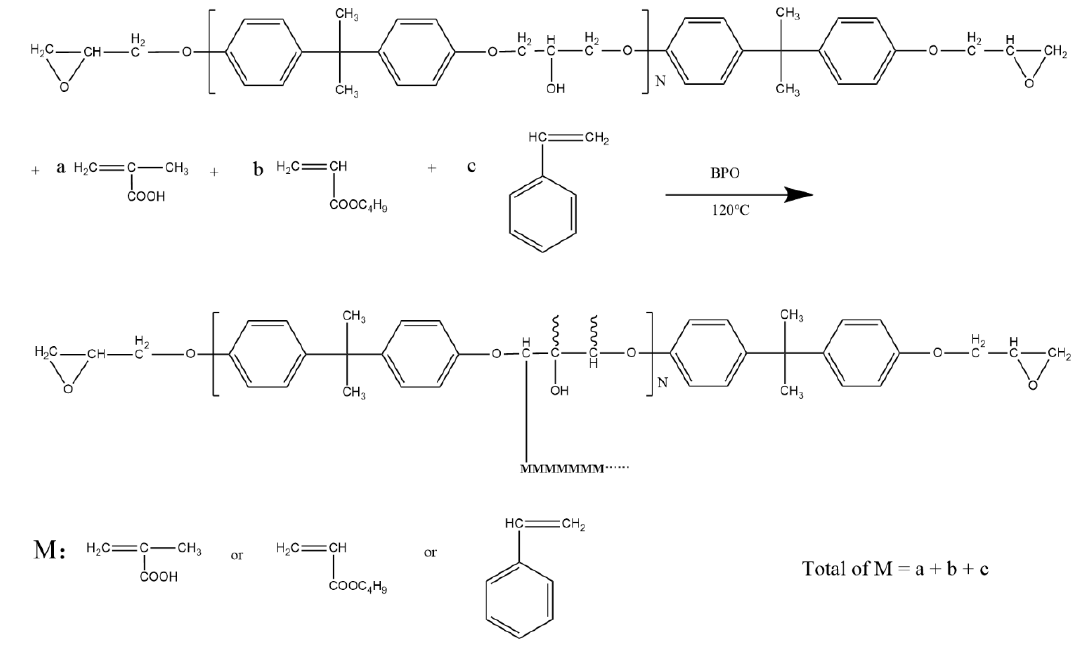
Figure 2. Schematic diagram of epoxy–acrylic acid graft copolymerization reaction. Neutralization reaction: The product was cooled to 50 °C after the grafting reaction, then 6.4 g of N , N -dimethylethanolamine, and 3.7 g of a mixed solution of ethylene glycol